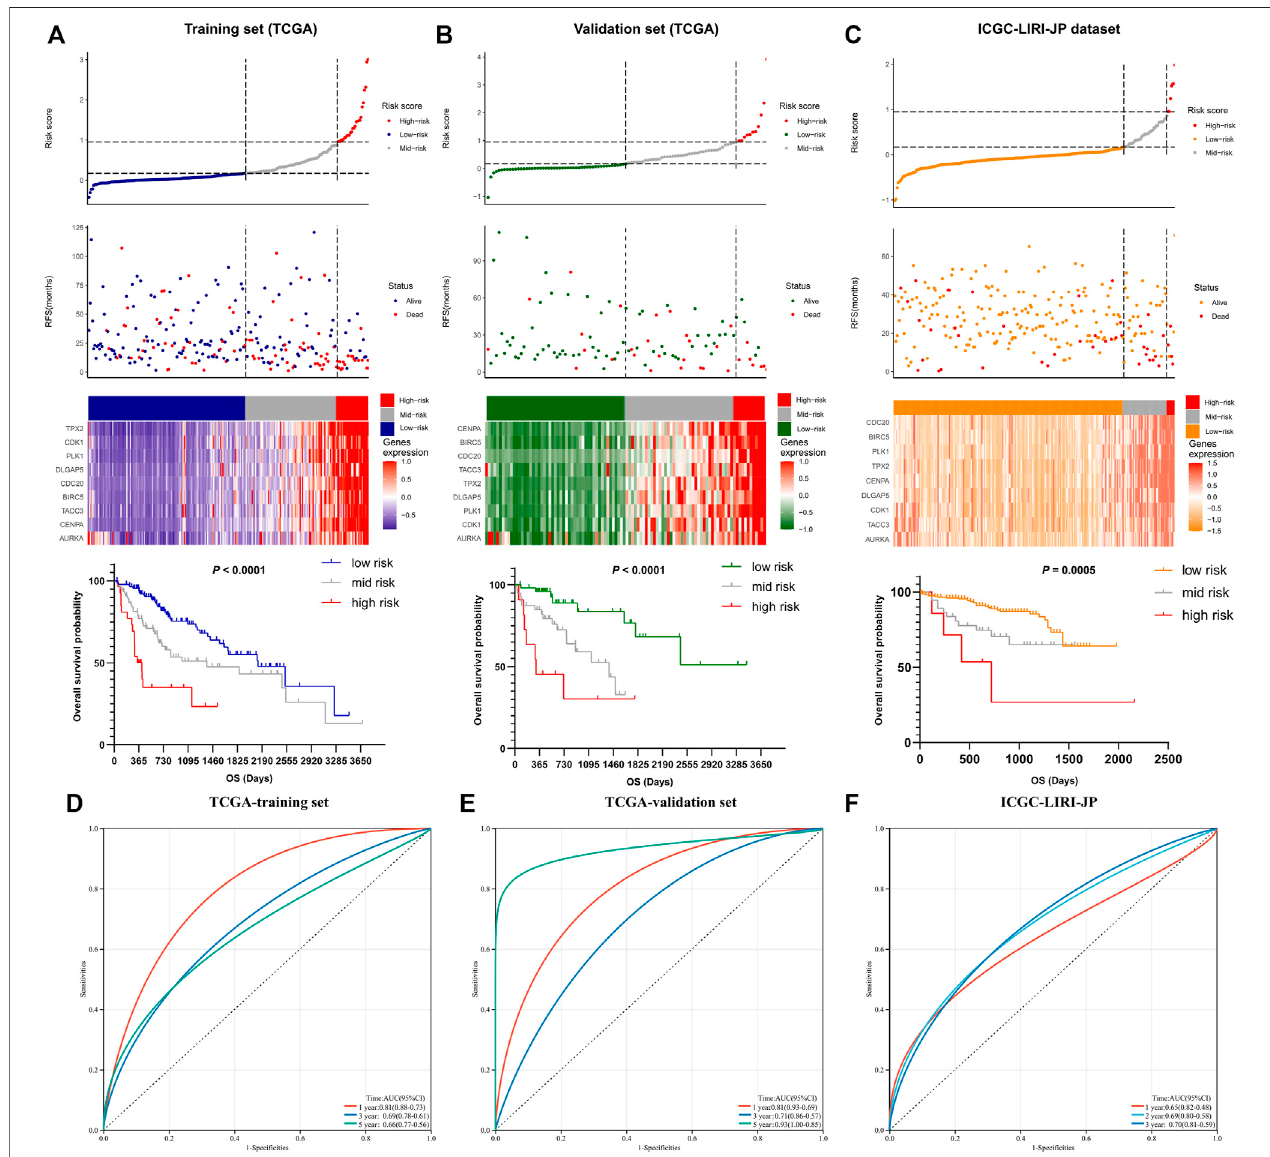
FIGURE 5 | The prognostic signi fi cance of the nine-gene risk scoring model. (A) The distribution of risk scores and survival status of liver cancer patients in the training set. HCC Patients with a higher risk score have a lower overall survival rate. (B , C) The distribution of risk scores and survival status of liver cancer patients in validation set. A higher risk score in HCC patients also have a lower overall survival rate. (D – F) The ROC curves of the training set and two validation